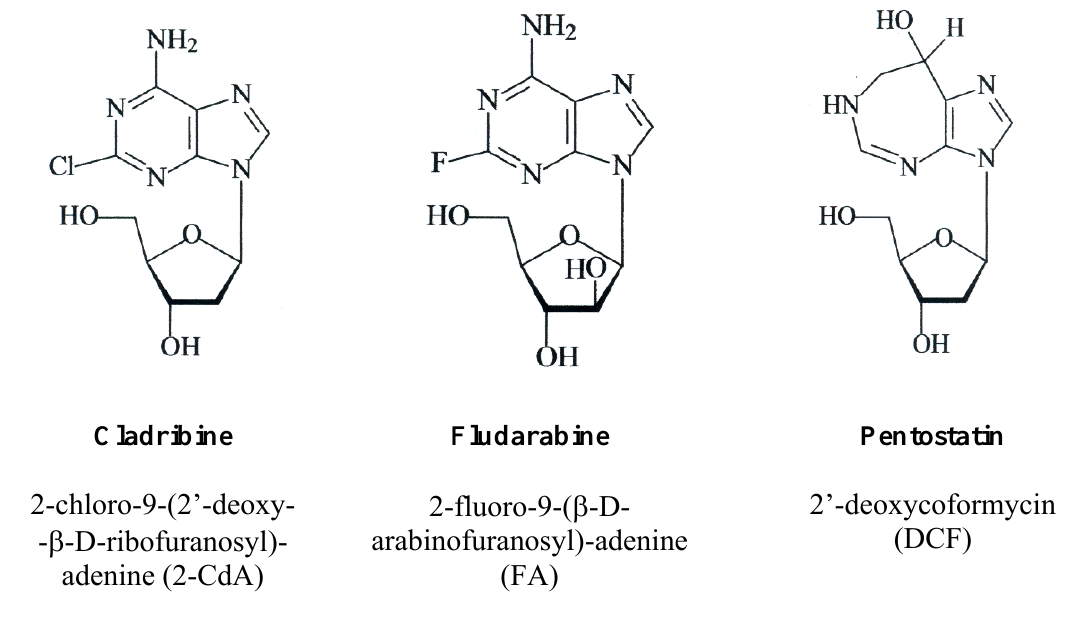
Figure 1. Structures of older nucleoside analogues: cladribine, fludarabine and